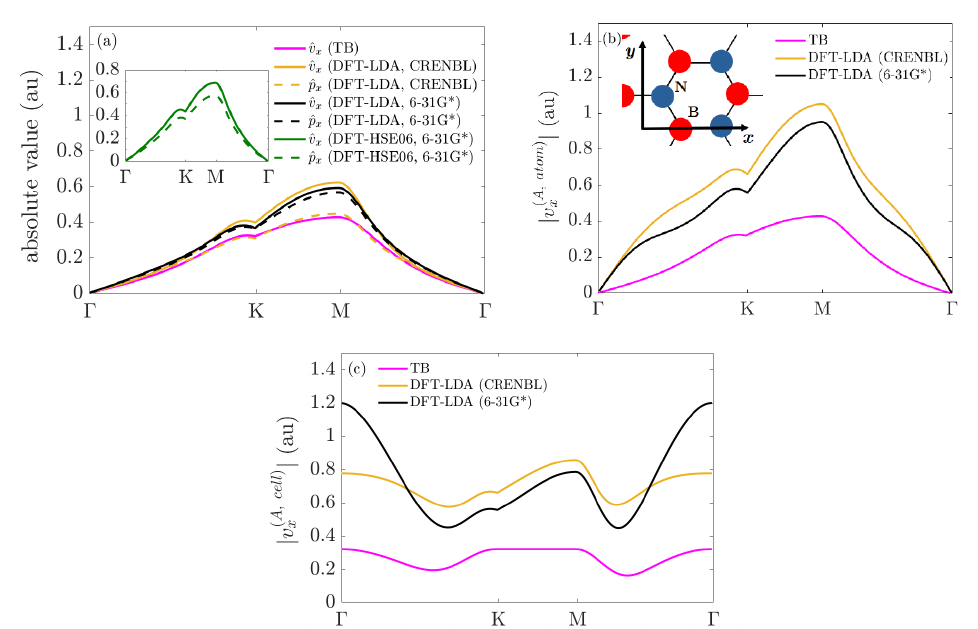
Figure 2: Absolute value of matrix elements for the band-gap transition along the Brillouin zone of monolayer hBN. (a) Velocity and momentum matrix elements for the two DFT calculations presented in 1 [ the inset show an extra DFT case using the HSE06 functional (see main text) ] and in the tight-binding approximation (b) Same for the first term of Eq. (21) in the atom gauge [ see. Eq. (23) ] . (c) Same as (b) but in the cell